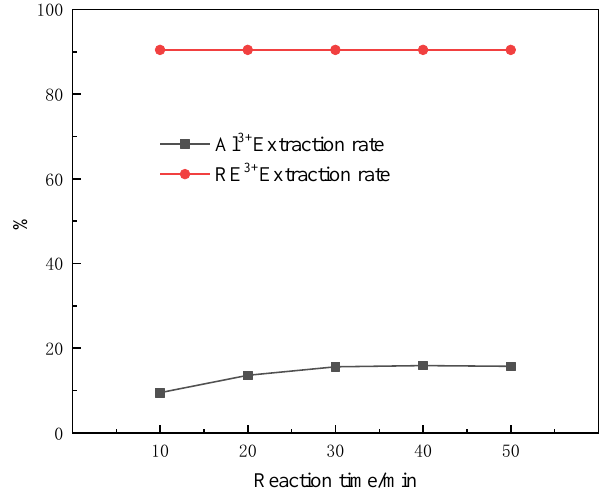
Figure 6. Effect of reaction time on the separation of rare earths and aluminum.